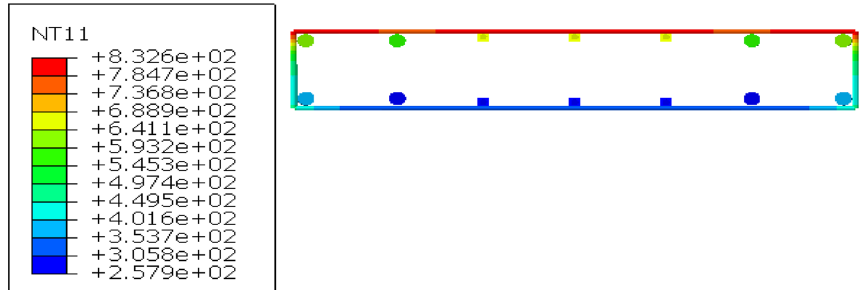
Fig. 32 Temperature distributions on the